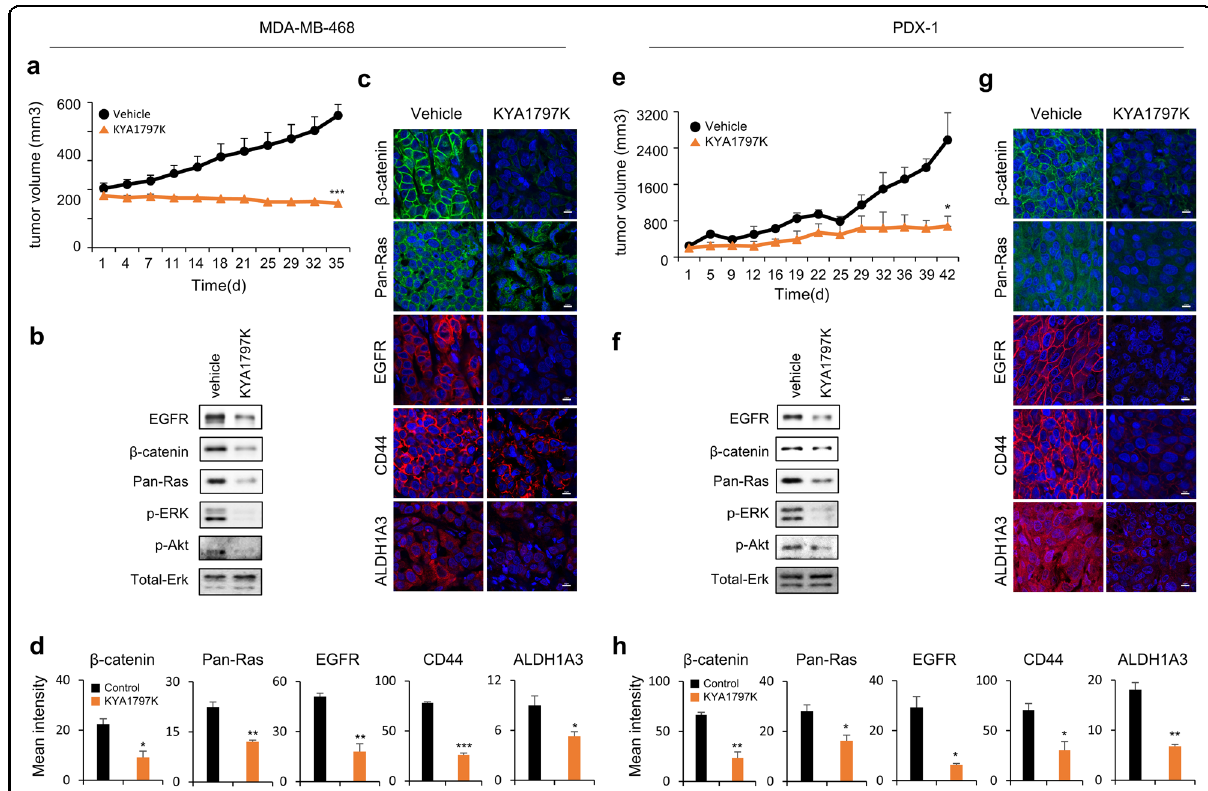
Fig. 5 Effects of KYA1797K on the growth of tumors derived from a TNBC cell line xenograft and a patient-derived xenograft (PDX). Mice- bearing TNBC tumors established from MDA-MB-468 cells or patients who showed resistance to adjuvant chemotherapy were treated with vehicle or KYA1797K (25 mg/ml) when the tumor burden reached a volume of 150 – 200 mm 3 (MDA-MB-468: vehicle n = 3, KYA1797K n = 4; PDX-1: vehicle n = 3, KYA1797K n = 3). KYA1797K was administered as described in “ Materials and methods ” . Subcutaneous tumor volumes were measured using calipers. a , e Tumor volumes were measured for 35 days (MDA-MB-468) or 42 days (PDX-1). b , f IB analyses with the indicated antibodies using WCLs of MDA-MB-468 cells or PDX-1 tumors. IHC analyses were performed on formalin- fi xed 4- μ m paraf fi n sections of tumors-derived MDA-MB-468 cells ( c , d ) or PDX-1 ( g , h ) using the indicated antibodies. Mean fl uorescence intensity for each marker was quanti fi ed by using a ZEN microscope software (Carl Zeiss Microscopy). Data values represent the mean ± SEM. * P < 0.05, ** P < 0.005., *** P <